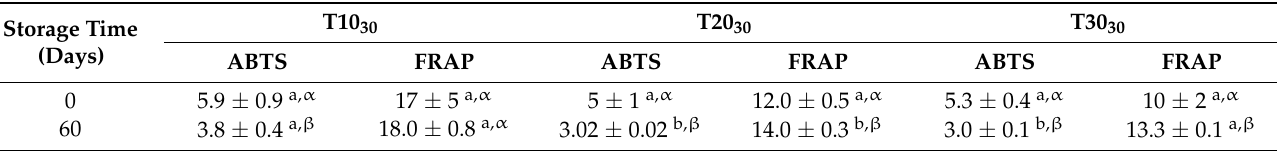
Values of ABTS are expressed as mM Trolox/L of juice and values of FRAP as mM Fe 2+ /L of juice. The rows with different lowercase letters (a, b) for the same antioxidant assay are significantly different at p < 0.05 based on Student’s test. The columns with different symbols ( α , β ) for the same initial extraction time and different storage times are significantly different at p < 0.05 based on Student’s